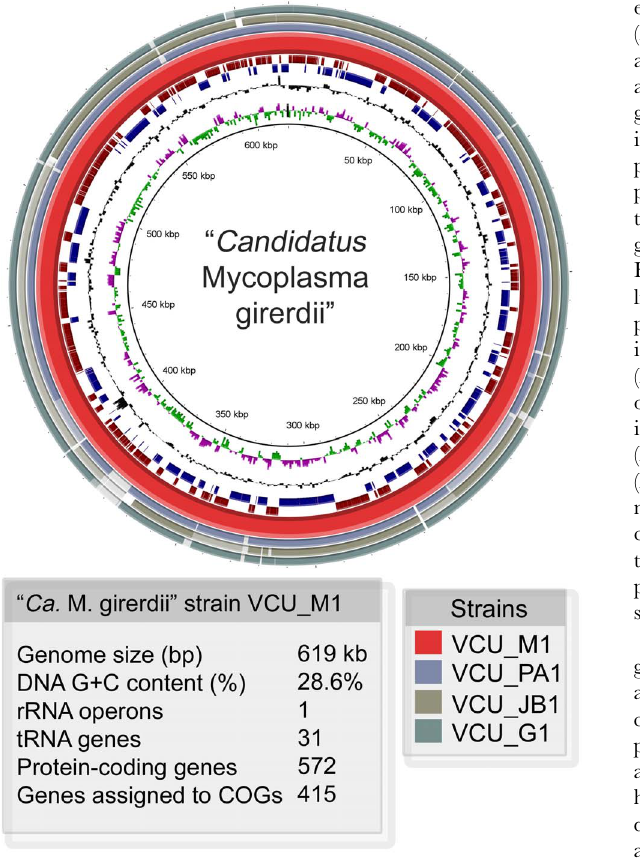
Figure 3. Representation of ‘‘ Ca. M. girerdii’’ genomes. A circular representation of the ‘‘ Ca. M. girerdii’’ reference genome (strain VCU_M1) assembled from metagenomic sequences from a mid-vaginal sample. Position 1 is set to the start of the dnaA gene. Outermost circles (1–3) show the alignment (97% or greater identity) of contigs of three different strains from metagenomic assemblies from mid-vaginal samples containing high proportions of ‘‘ Ca . M. girerdii’’. Circle 4 (red) represents the reference strain (VCU_M1). Circles 5 (dark red) and 6 (blue) represent the predicted coding sequences in the forward and reverse orientations respectively. Circle 7 (black) shows the GC content, and circle 8 shows GC skew (pink (-), green ( + )). ( e.g ., Asiatic elephant and Somali wild ass) are all models of